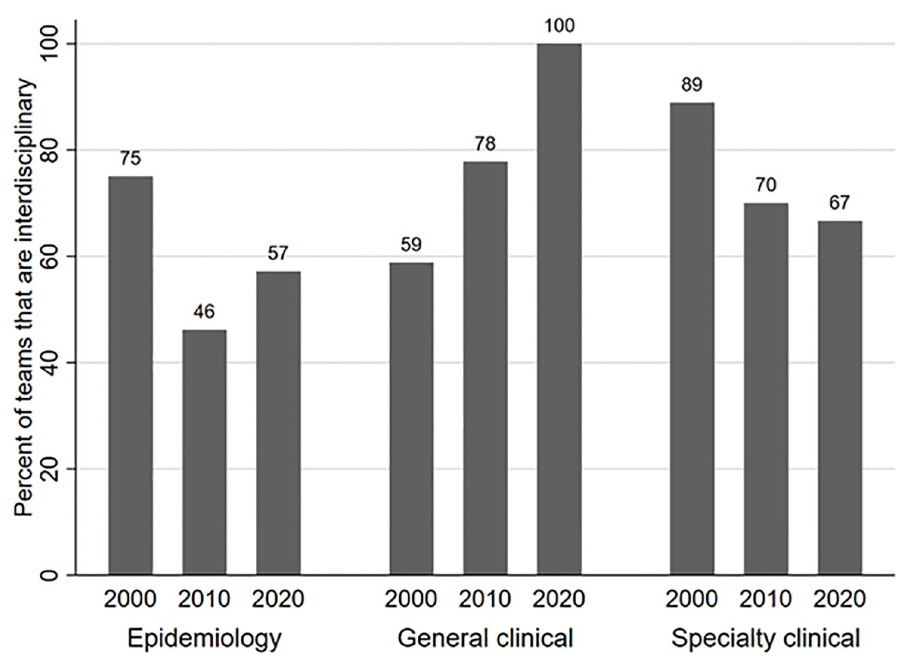
Fig 3. Percent of team that were interdisciplinary by type of journal and publication year. Interdisciplinary teams collectively had at least one author formally trained in each epidemiology, biostatistics, and clinical